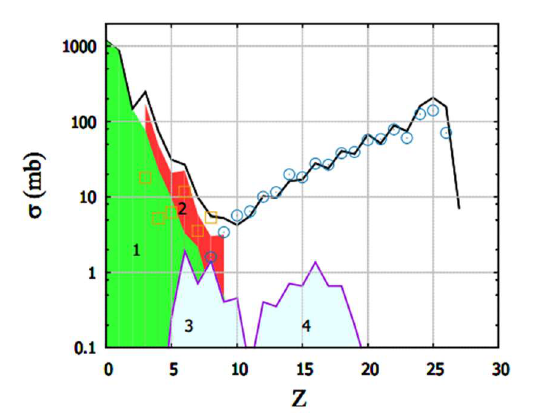
Figure 4 . (Color online) Contributions to the calculated total Z-distribution at 1.0 GeV/A. Emission of particles and fragments in their ground states (region 1), excited bound (region 2) and binary decays (regions 3 and 4) are shown. Experimental data [4,5] are shown with symbols.